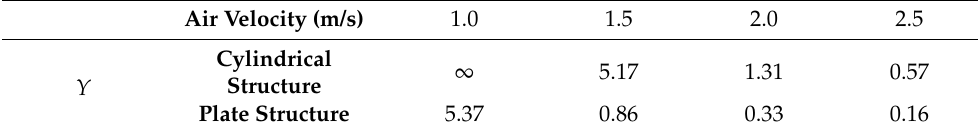
Table 4. The calculation results of quality factor Y .